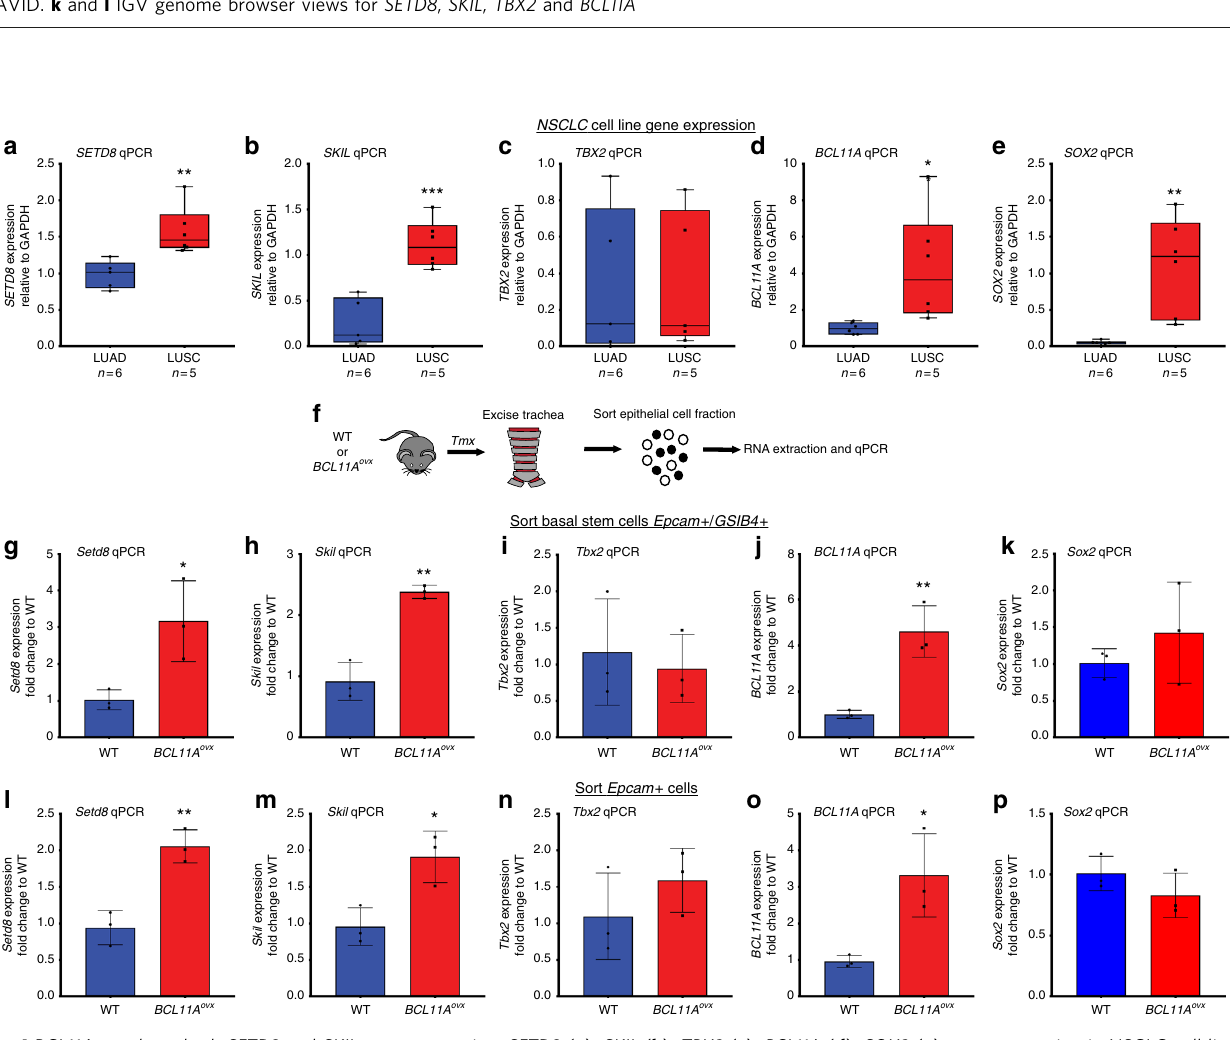
Fig. 3 BCL11A and SOX2 occupy independent and common loci in the genome of LUSC cells. a and b Western blot showing SOX2 and BCL11A expression in SOX2-KD in LK2 ( a ) and H520 ( b ) cells transfected with control (scramble), shRNA1 or shRNA2 vectors. c and d BCL11A expression in SOX2 -KD LK2 ( c ) and H520 ( d ) cells. e Western blot showing BCL11A rescue in SOX2 -KD cells. Doxycycline (Dox) inducible BCL11A overexpression vector was transfected into control and SOX2 shRNA1 LK2 cells and Dox treatment was performed for 48 h. f Graph depicting 3D matrigel assay in control, SOX2-KD and BCL11A rescue cells indicating a partial rescue in SOX2-KD , BCL11A overexpressing cells. g Graph indicating partial rescue of tumour size from BCL11A overexpressing SOX2-KD cells injected subcutaneously. The whiskers indicate the range of the data and the line represents the median. h Images of actual tumours measured. Four mice per cell line were monitored for 15 days after which tumours were removed and measured. Data presented as mean ± s.d.